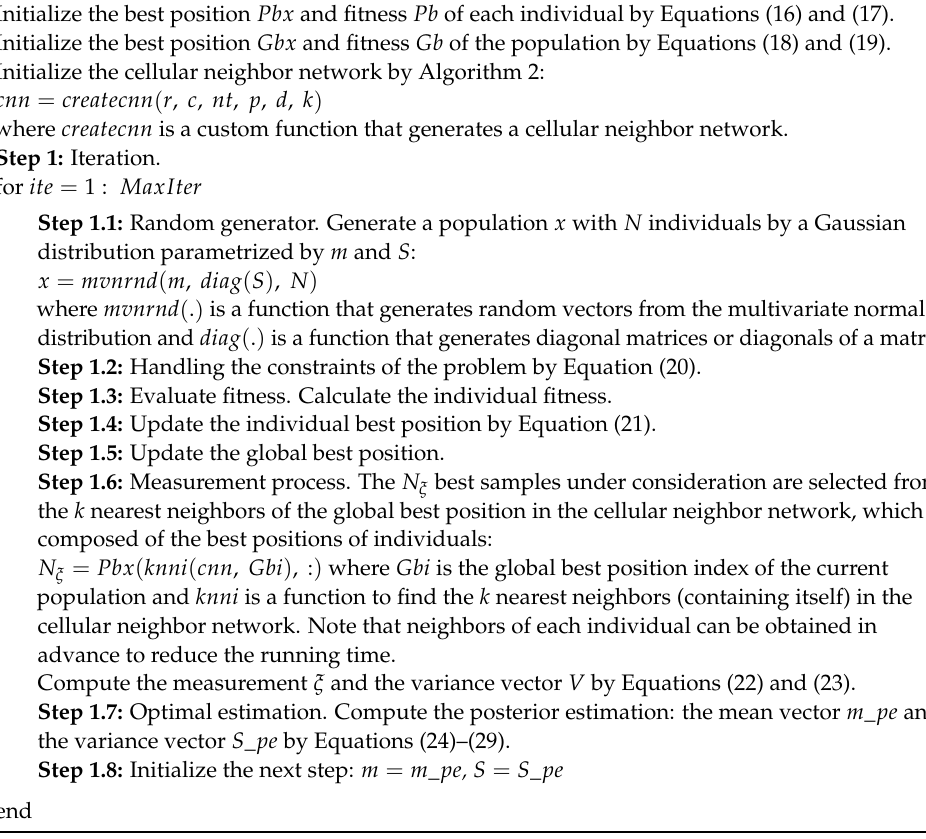
Algorithm 1 . The general pseudo-code of the